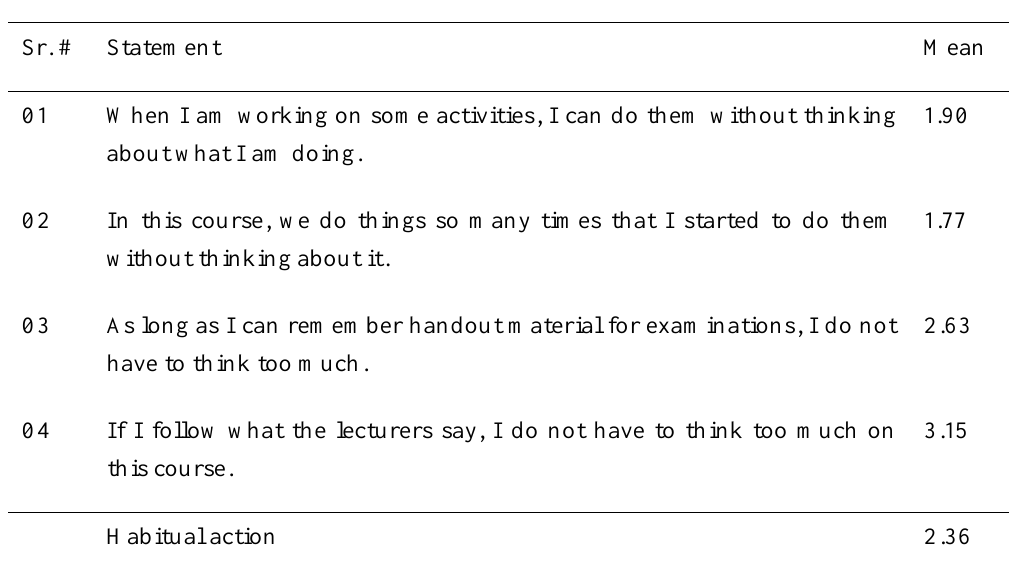
Students’ Thinking Practices Governed by Habitual